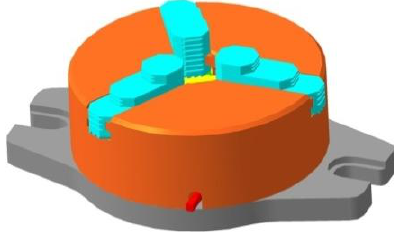
Figure 5. Adjustable locating-and-clamping module for locating of parts according to external cylindrical